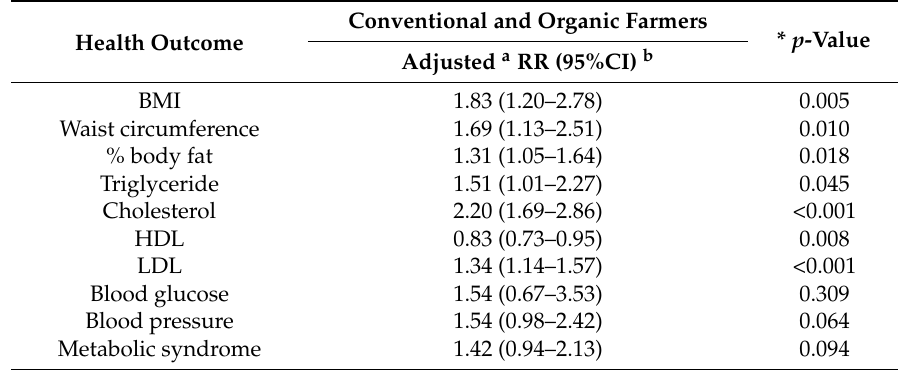
Table 6. Comparison of health outcomes between conventional ( n = 214) and organic farmers ( n = 222) using a generalized linear model for probability of abnormal blood test